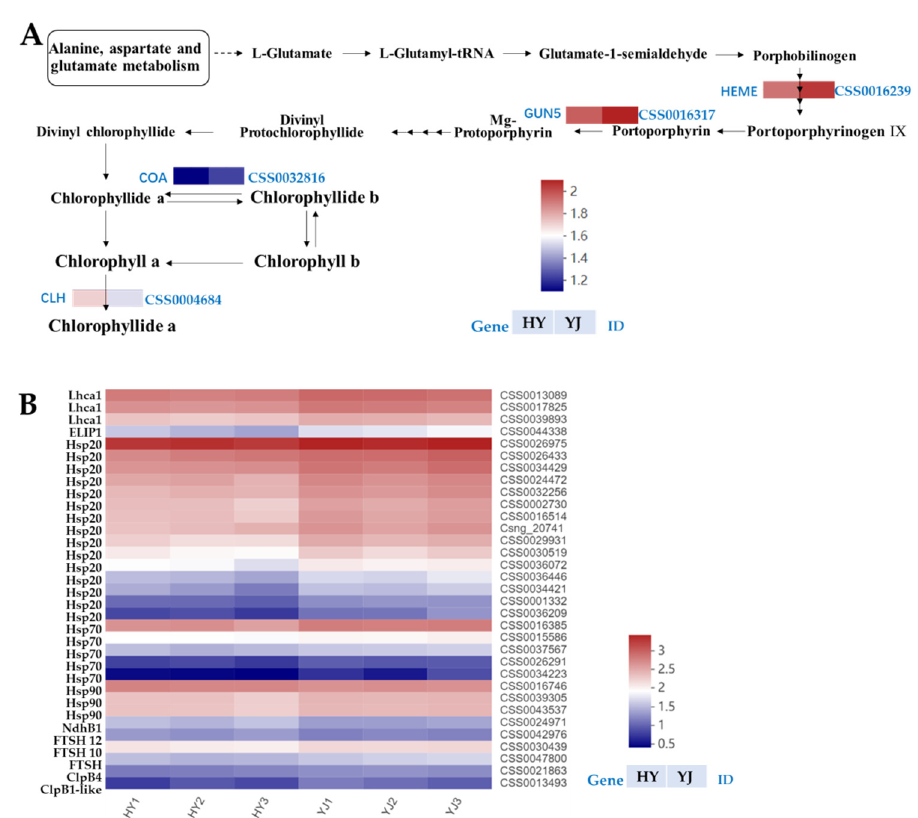
Figure 6. Expression profiles of DEGs involved in chlorophyll metabolism ( A ) and photosynthesis ( B ) photosynthesis-antenna proteins and photosynthetic proteins involved in endoplasmic reticulum pathway in ‘Yinghong 9’ and ‘Huangyu’. YJ is ‘Yinghong 9’, HY is ‘Huangyu’.